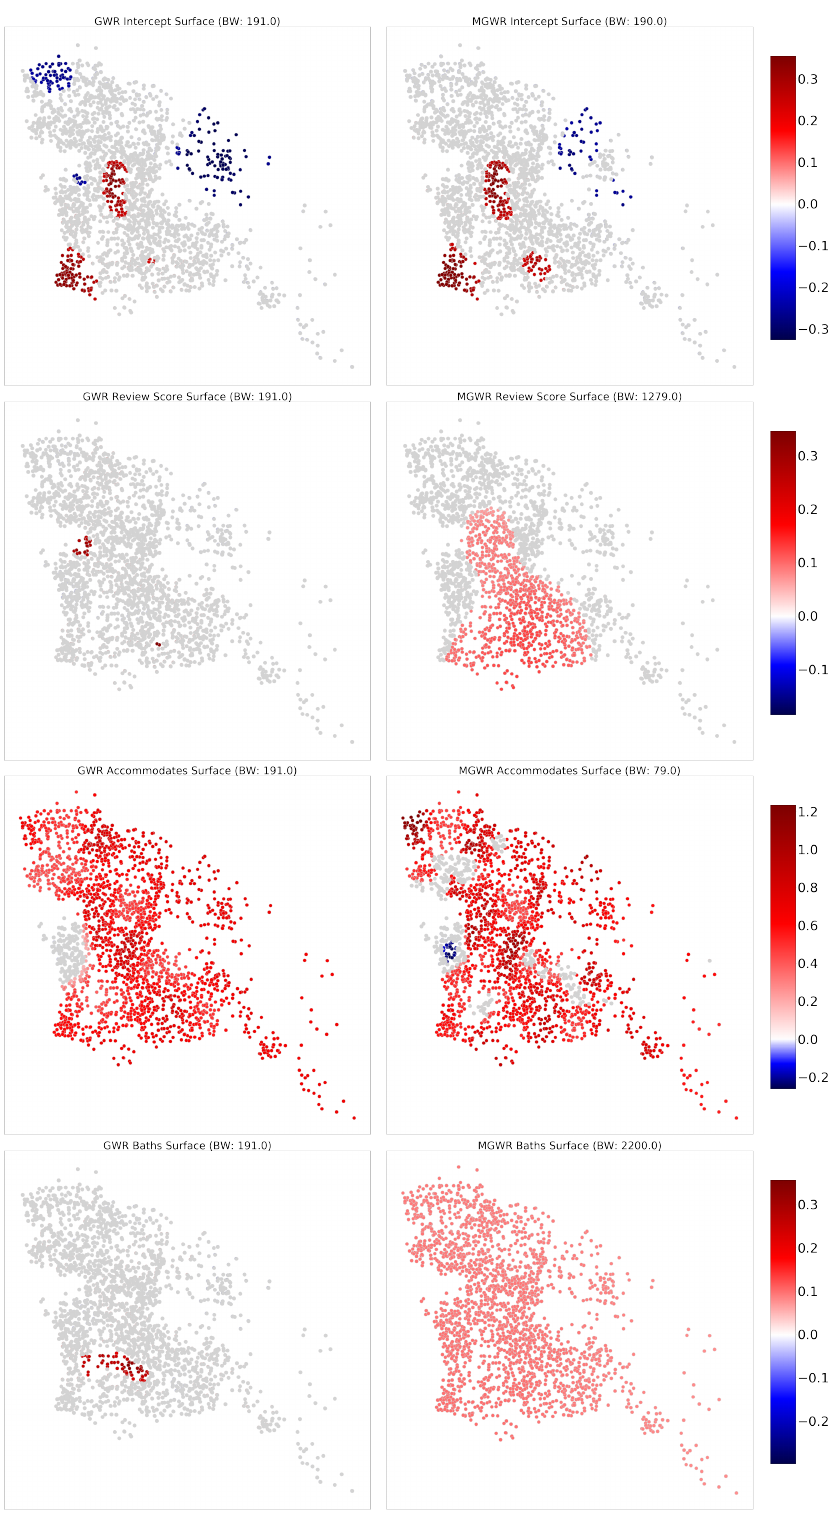
Figure 13. Parameter estimates for GWR ( left ) and MGWR ( right ) for Berlin